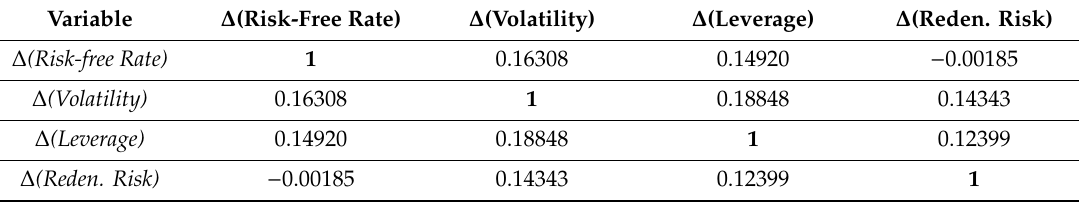
Table A5. Correlation matrix: period August 2007–October 2009 (492 Obs.).